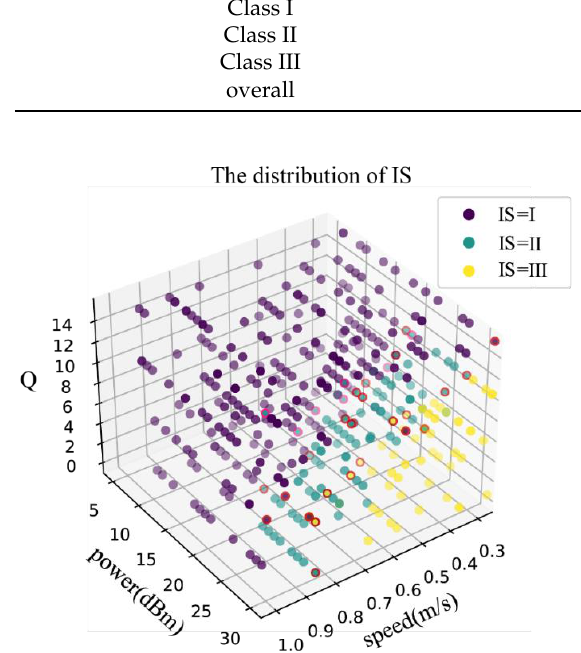
Figure 13. The actual distribution of the IS.